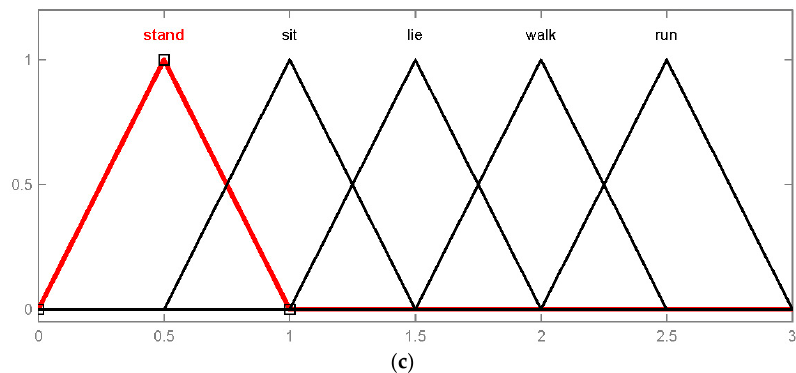
Figure 3. Distribution of measured signals of WSN sensor with respect to the fuzzy set of the feature in activity recognition: ( a ) distribution sample of probability density function of tilt angle measured by mote B ( θ B ) for “stand” and “sit” postures; ( b ) membership functions of input feature θ B ; ( c ) membership functions of output features for defuzzification.